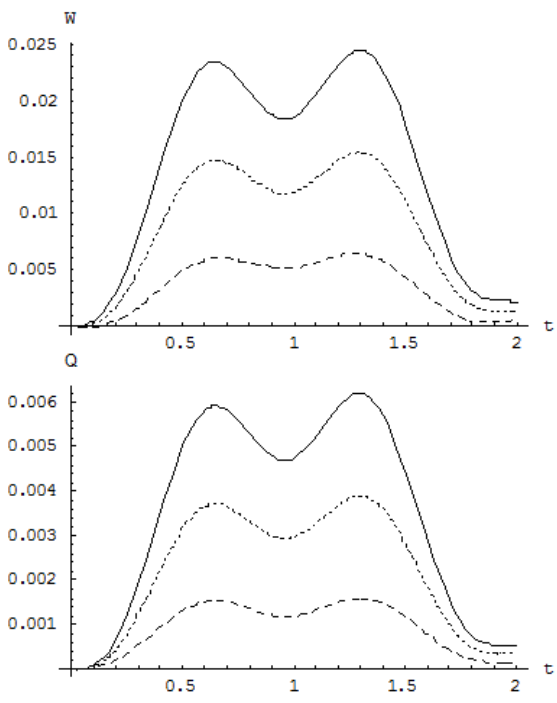
Figure 12: The influence of the radius of curvature for υ = 20 m/s, e H = 1.5 m, e V = 1.2 m and R = 50 m ( ___ ), R = 100 m (..... ), R = 150 m ( - - - ).